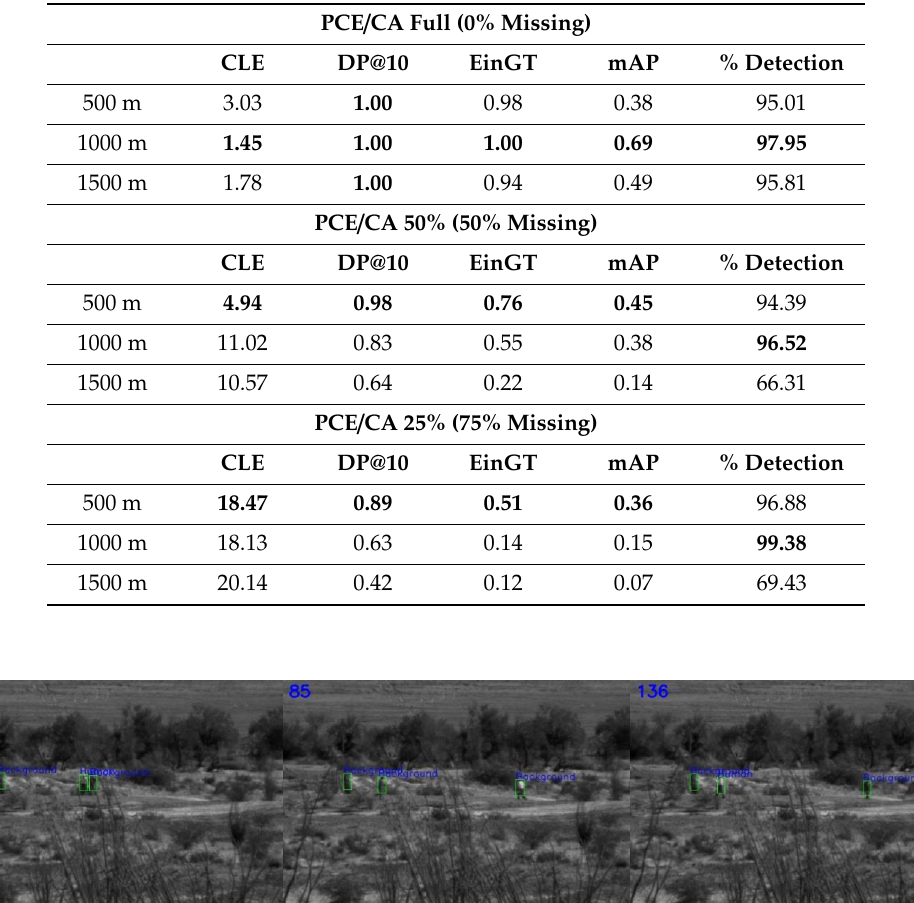
Table 1. Detection using optical videos. Bold numbers indicate the best results among the di ff erent ranges. Bold numbers indicate the best metric among all the ranges.